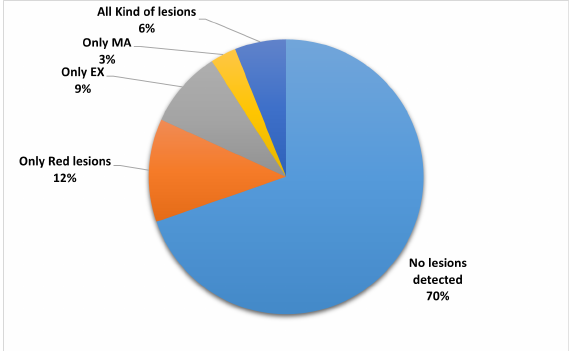
Figure 4. The ratio of studies that classified the DR lesions [47].